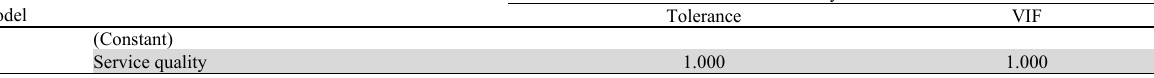
Multicollinearity Test